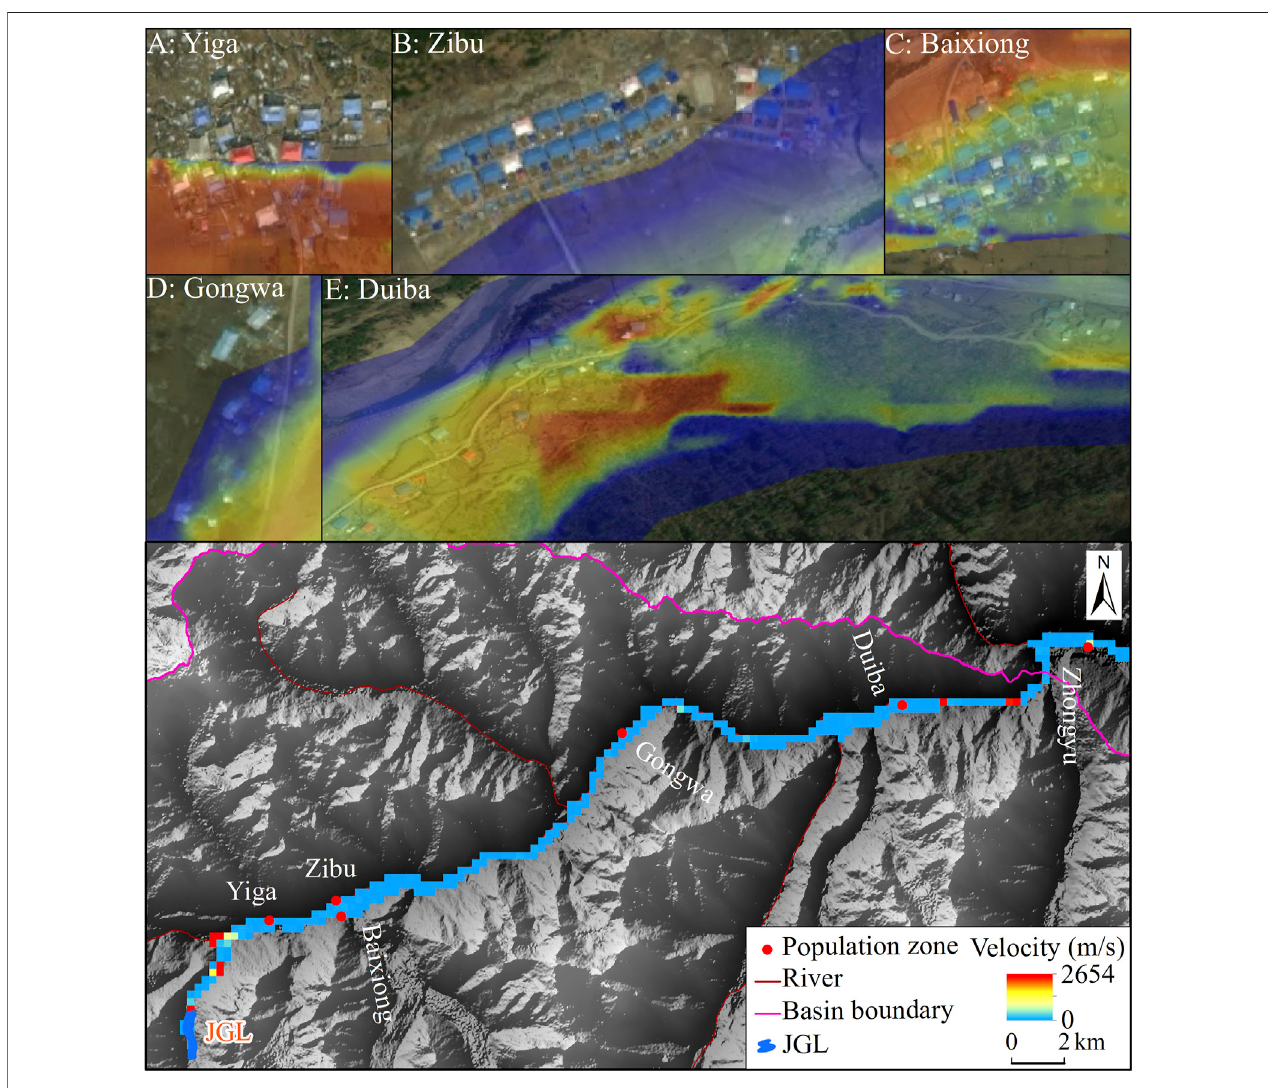
FIGURE 9 | Maximum velocity along the Niduzangbo river channel. Sub fi gure (A) – (E) are spatial distribution of maximum velocity in different villages.